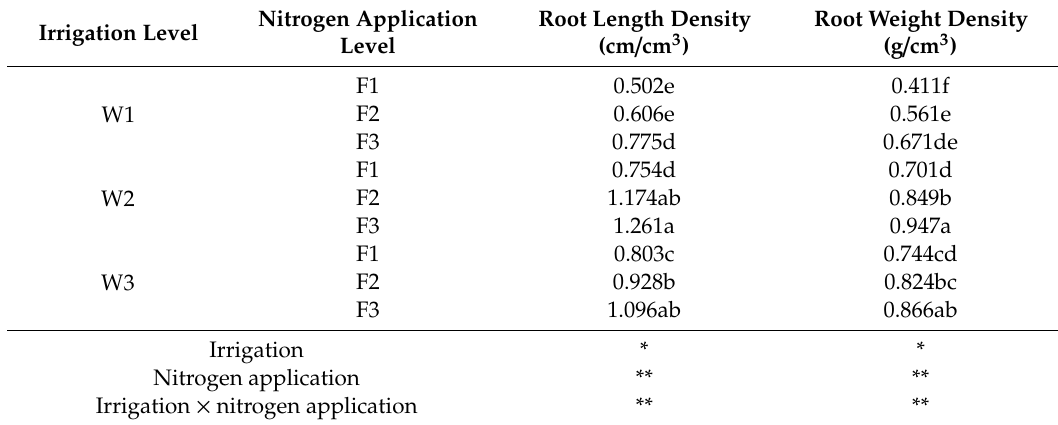
Table 3. E ff ect of water and nitrogen treatments on the root